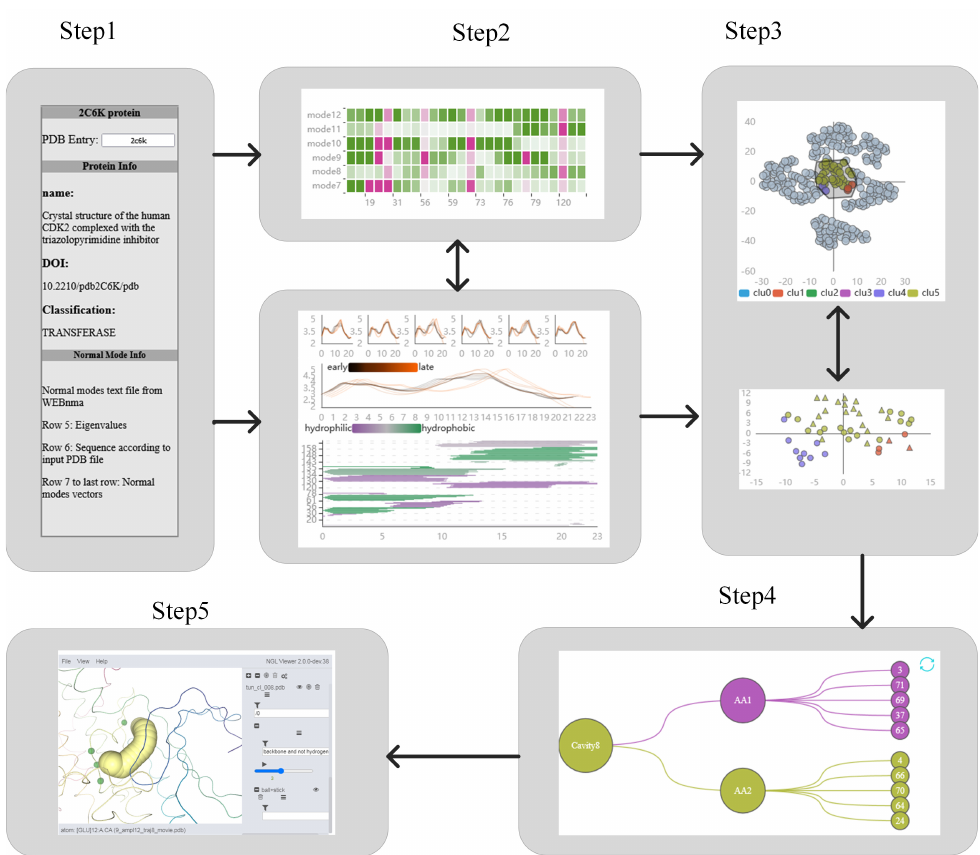
Figure 10. The interactive exploration process. Our exploration process is divided into 5 steps, namely, the overview of basic protein information, discovering the influence of cavity-lining amino acids on the cavity, identifying key amino acids, exploring the relationship among key amino acids and the cavity, and 3D